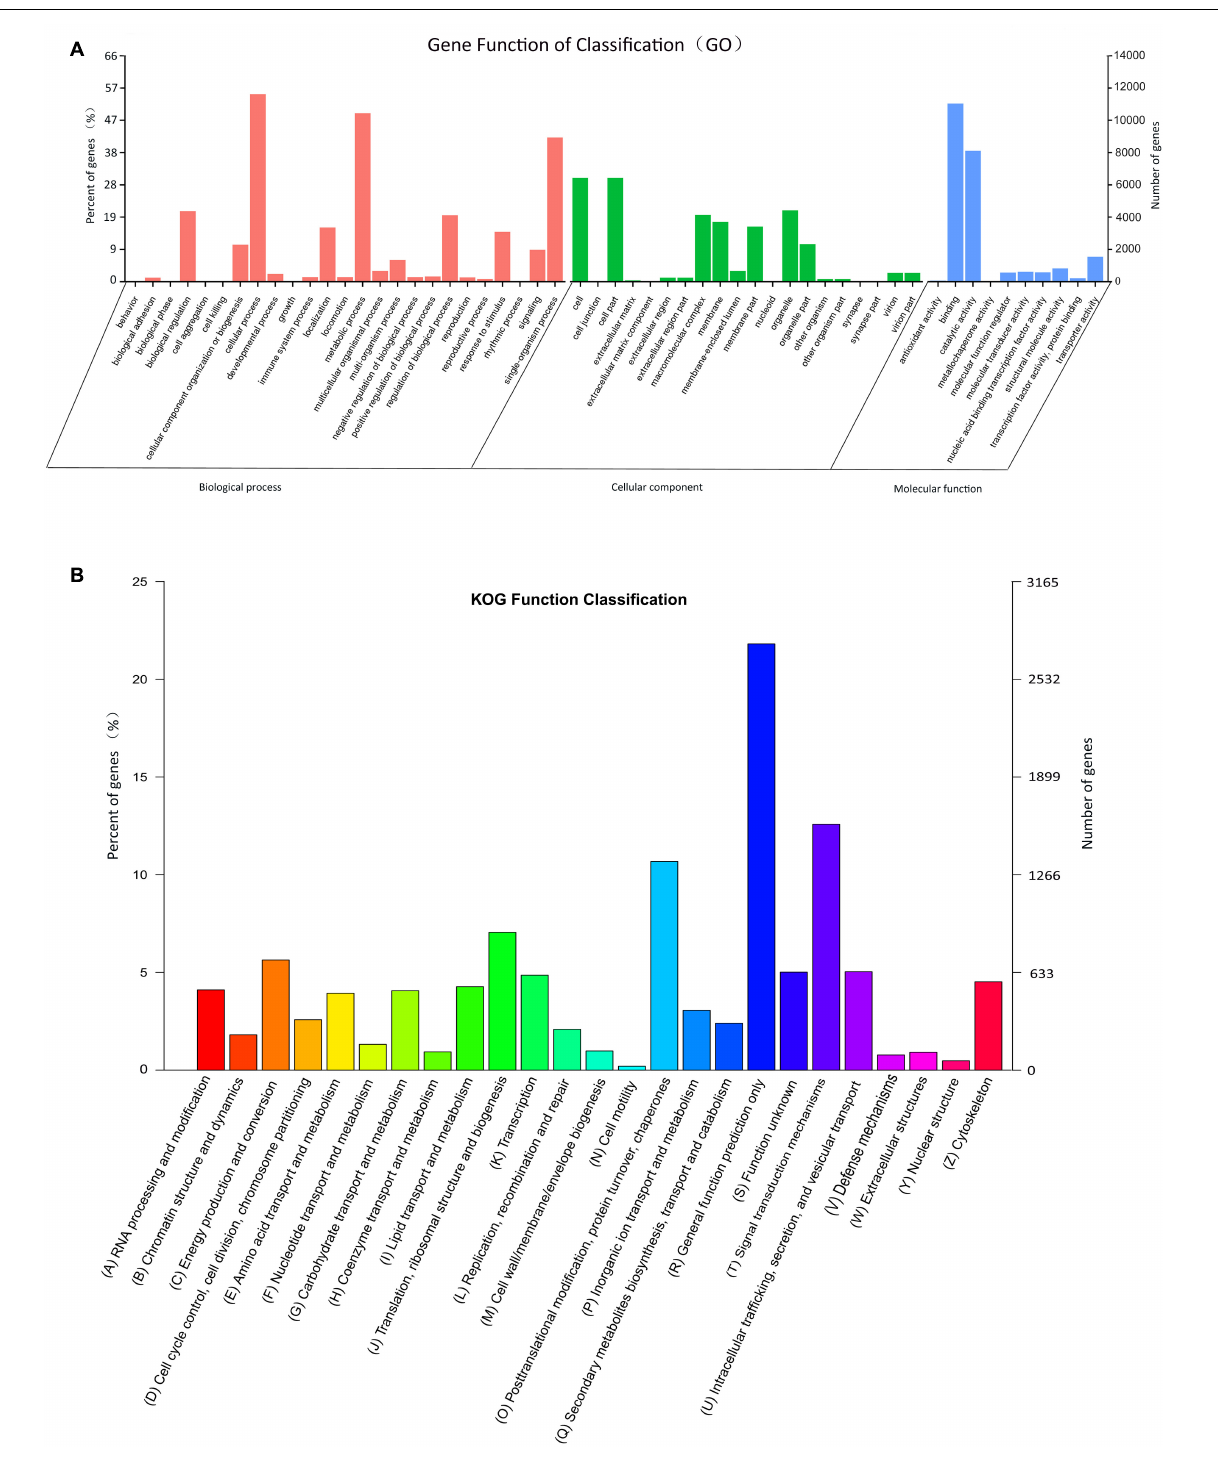
Frontiers in Physiology |